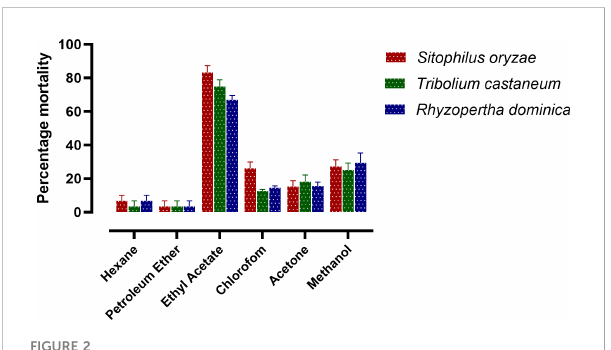
FIGURE 2 Fumigant toxicity of different extracts from D. indica leaves, at 50 mg/L, against S. oryzae, T. castaneum and R. dominica . (n=